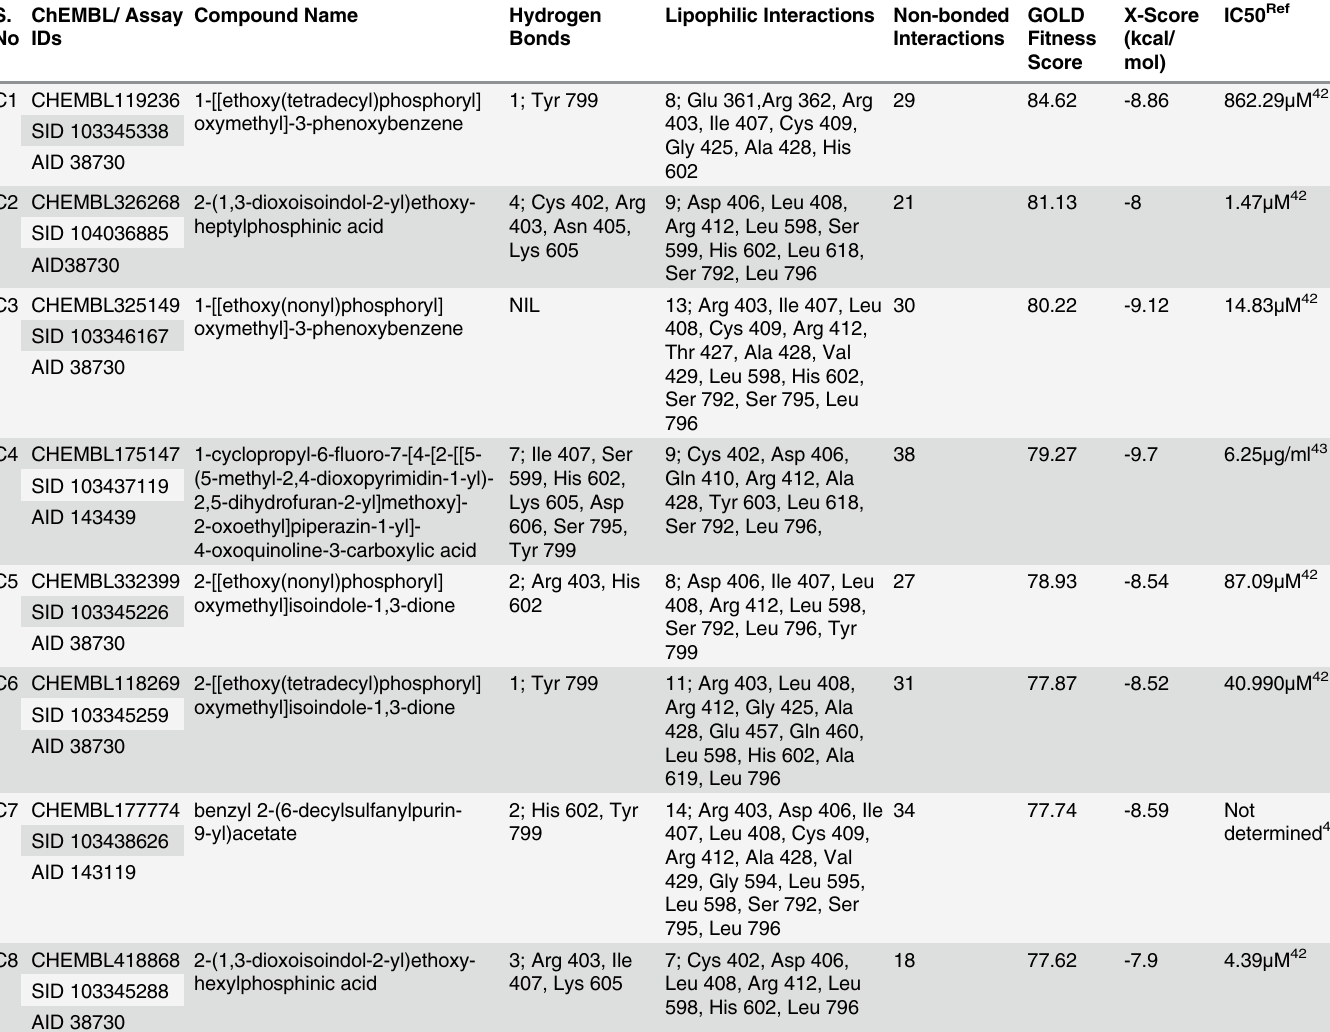
Table 1. Molecular Docking Results and Interaction Analysis for Identified putative anti-mycobacterium Inhibitors against Mtb